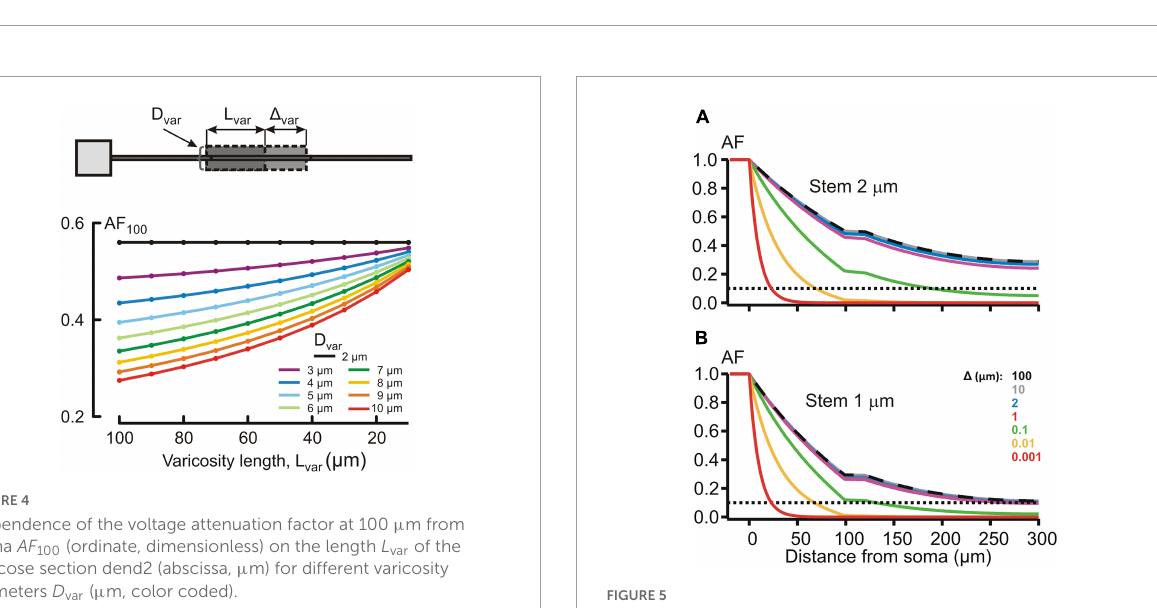
Attenuation factor AF(x) (ordinate, dimensionless) in function of the path distance coordinate x (abscissa, µ m) for different width/thickness (cid:49) ( µ m, color-coded) of the peri-dendritic layer of the interstitial conductive fluid between non-uniform dendrite and adjacent glia. (A,B) Plots for dendrites, which had the stem diameter of 2 and 1 µ m, respectively, and contained a varicosity